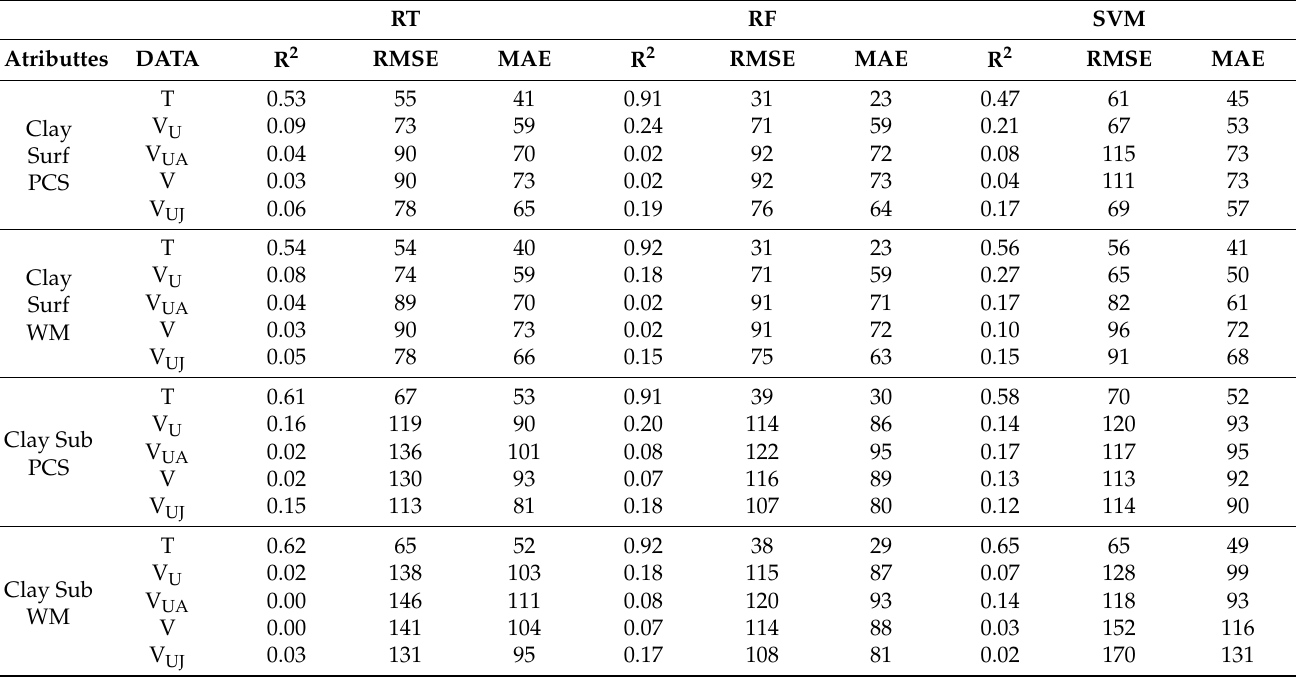
Table 7. Accuracy assessment of soil surface and subsurface clay content predictions using the Reference Area (RA) sampling